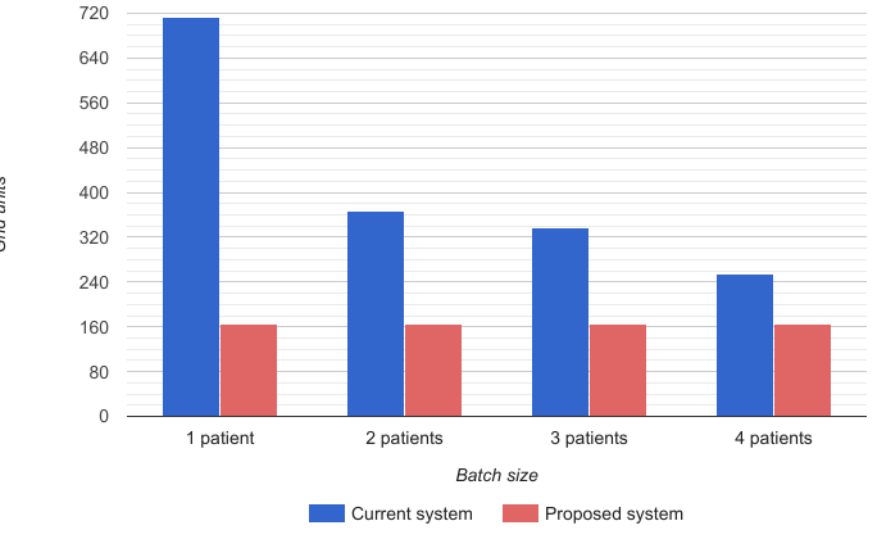
Figure 12. Time required for a doctor’s